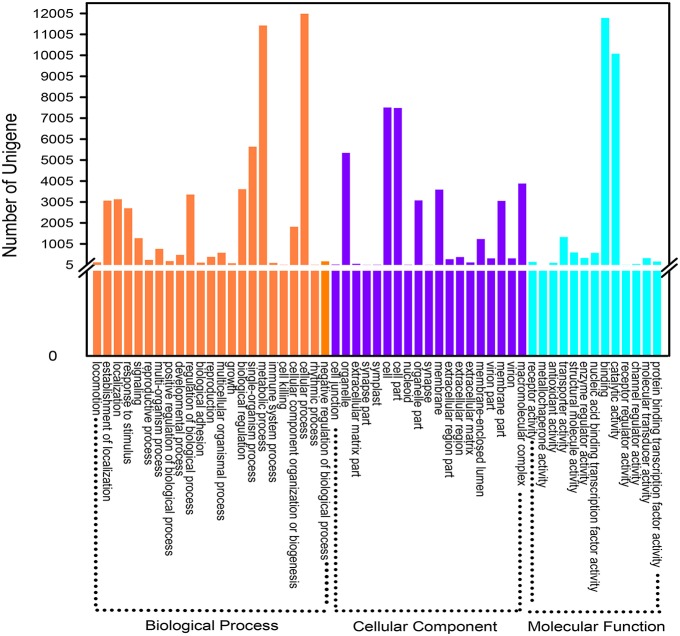
Gene Ontology classification of assembled unigenes. A total of 20,165 unigenes were categorized into three main categories: “biological process,” “cellular component,” and “molecular function”.